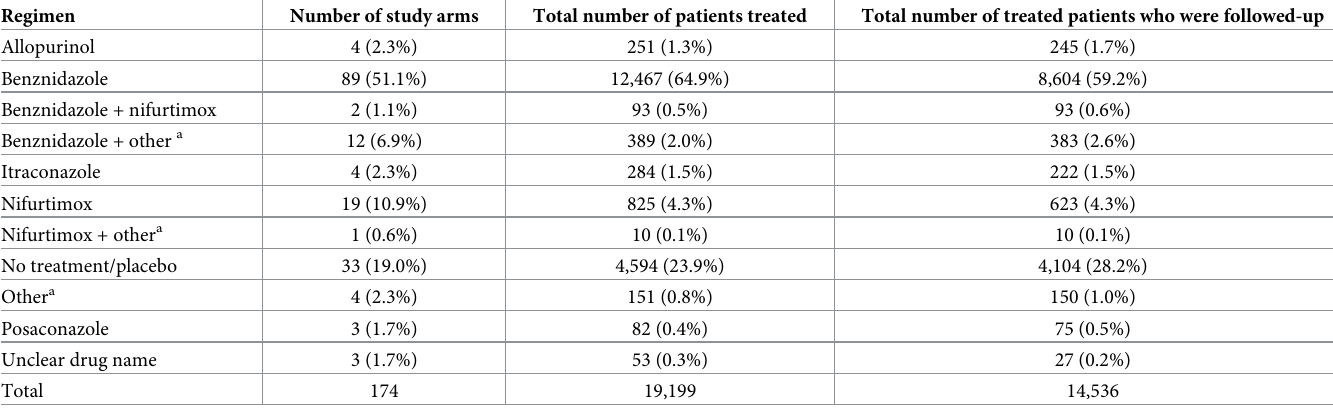
Table 2. Drug regimen tested in the studies included in the review.